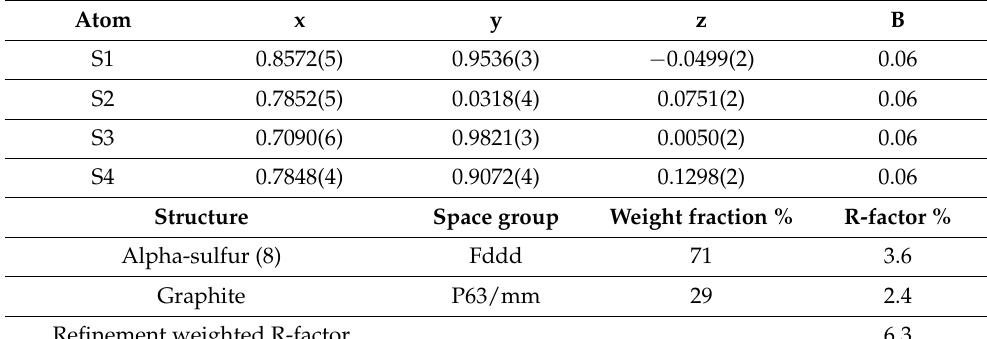
Table 2. X-ray diffraction parameters for S@RGO/GN.